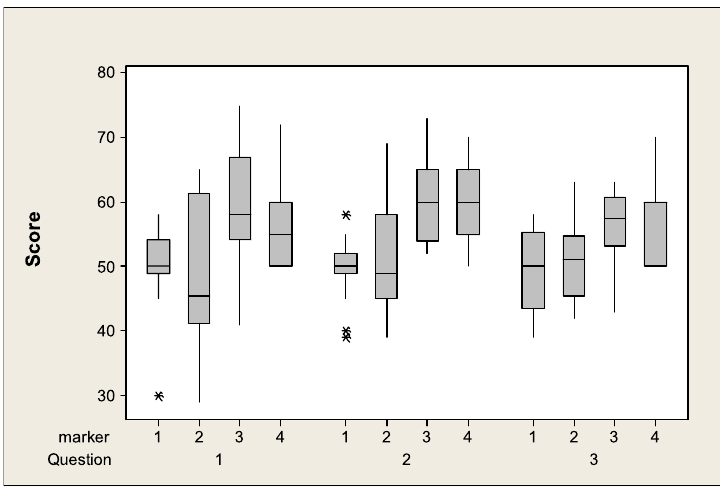
Figure 4. Boxplot of score by question then marker. Figure 3. Boxplot of score. Reusing the same data but presenting it question by question (Figure 4 ) suggests that no one question was marked in the same way by all markers. So is there a difference in how the markers approach typed or handwritten scripts?